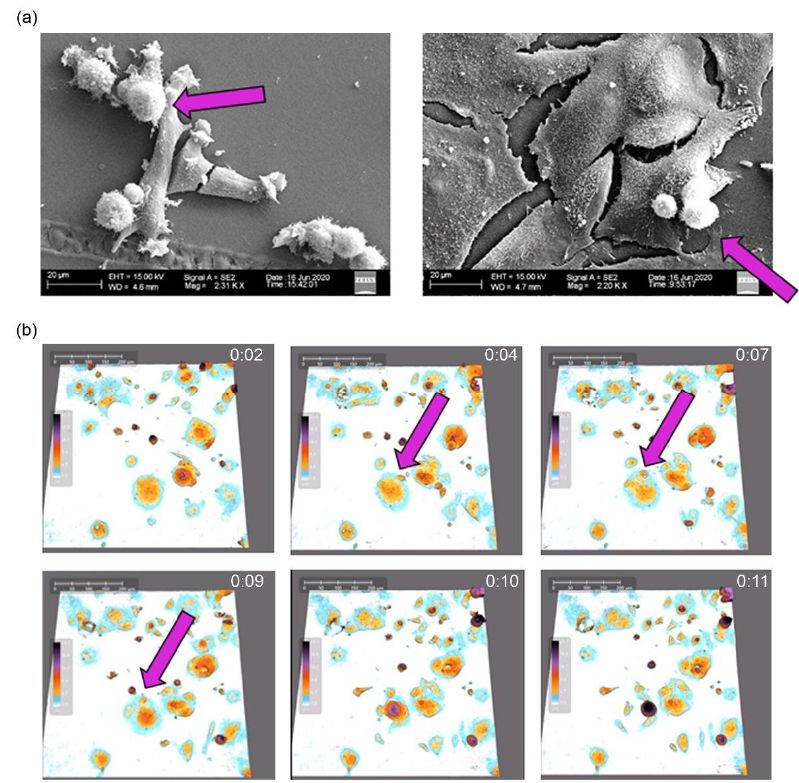
Figure 2. Atypical divisions of senescent/polyploid cancer cells. ( a ) Representative pictures of control MCF-7 breast cancer cells (on the left) and ones after treatment with IRI. Arrow indicates dividing cells. Pictures were taken on D8 with the use of scanning electron microscope. ( b ) Time lapse of asymmetric division of senescent MCF-7 breast cancer cells after IRI treatment was documented with holographic microscope HoloMonitor4. Time between frames: 20 min. Senescent cell with small budding offspring cells (pink